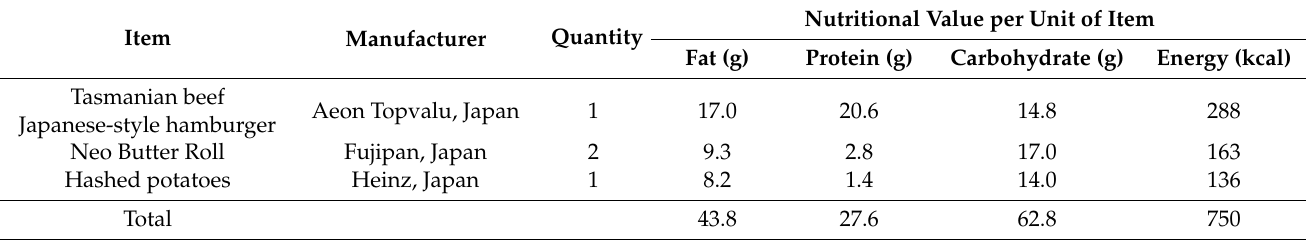
Table 2. Description of the standardized high-fat